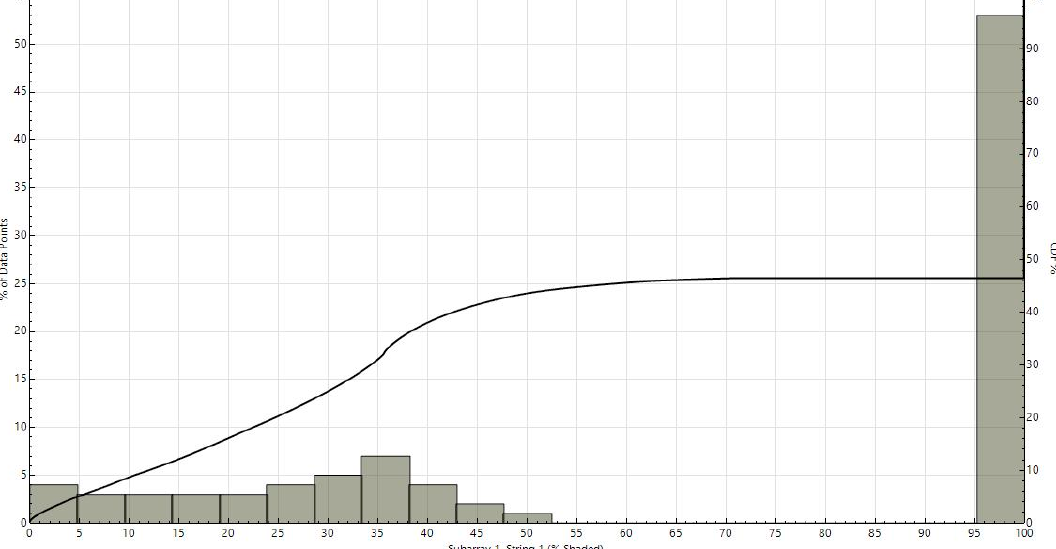
Figure A4. Time series (1 min step) shaded fraction histogram (zero-values excluded) for due southwest orientation.